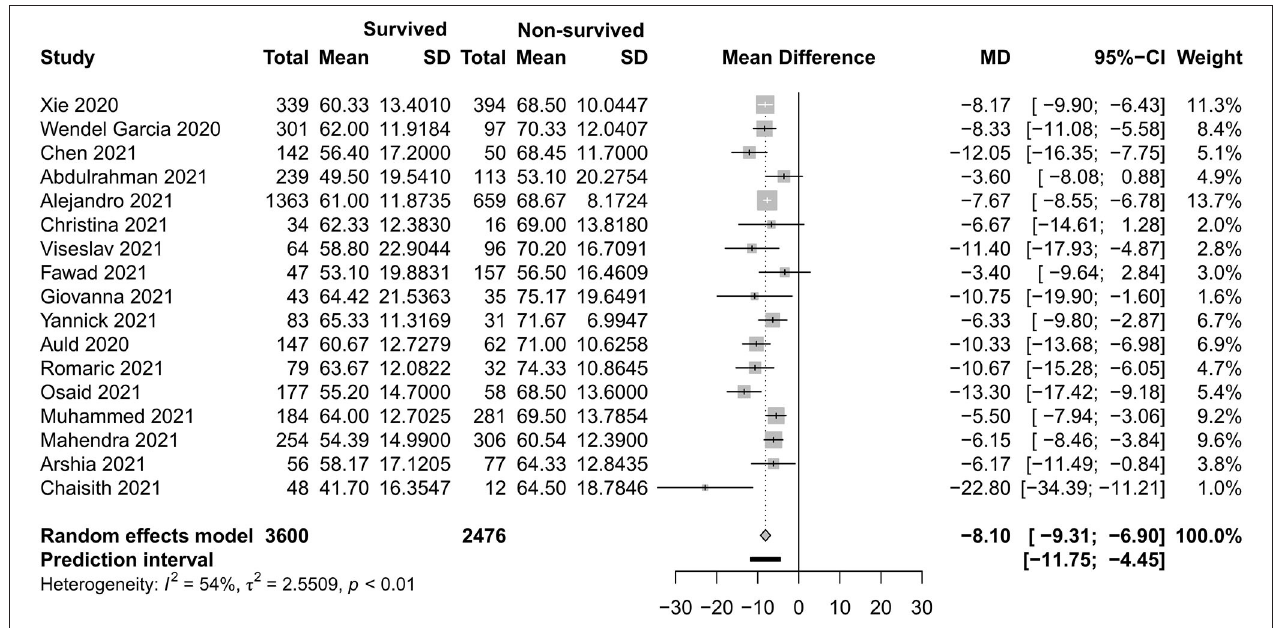
FIGURE 4 | Mean difference of age between survived and non-survived patients.